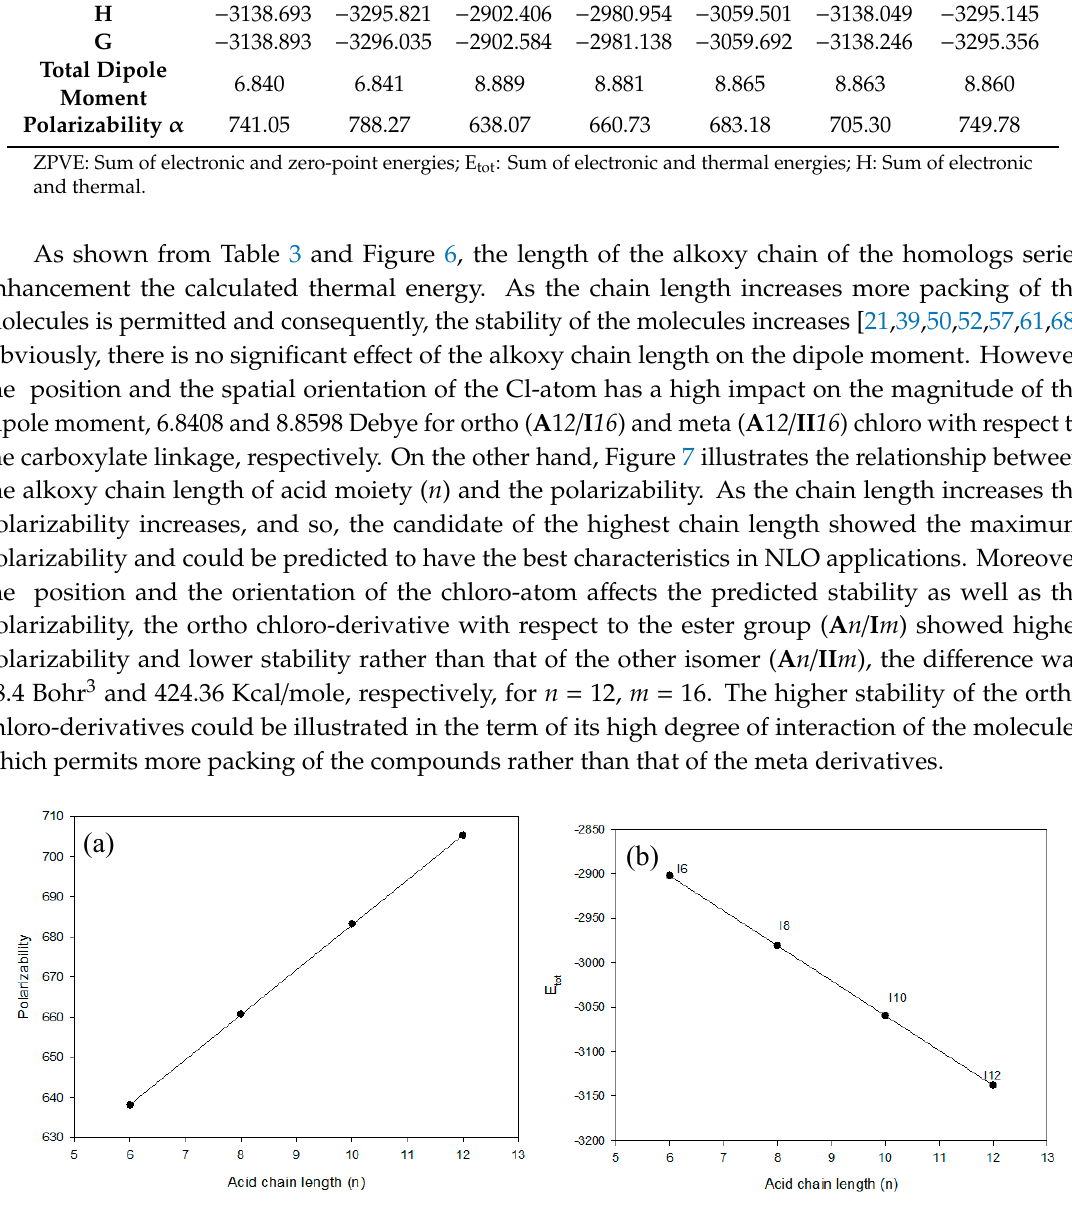
Figure 7. Dependence of the acid akoxy chain-length of SMHB complexes A n / II m on the ( a ) the calculated polarizability and ( b ) thermal energies.